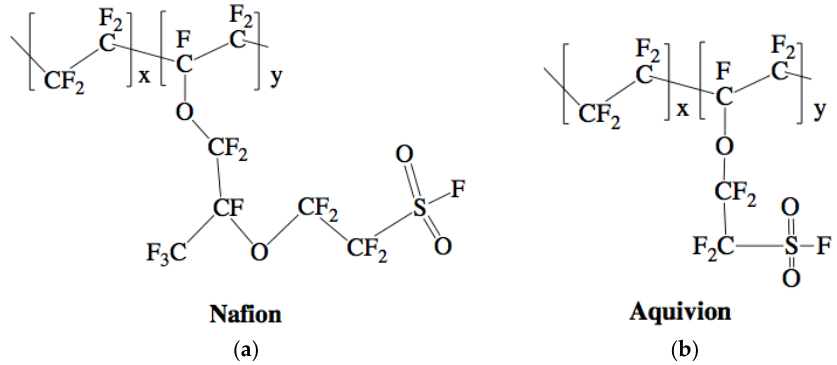
Figure 3. Chemical structure of Nafion ( a ) and Aquivion ( b ) un-activated, precursor forms [23,24].